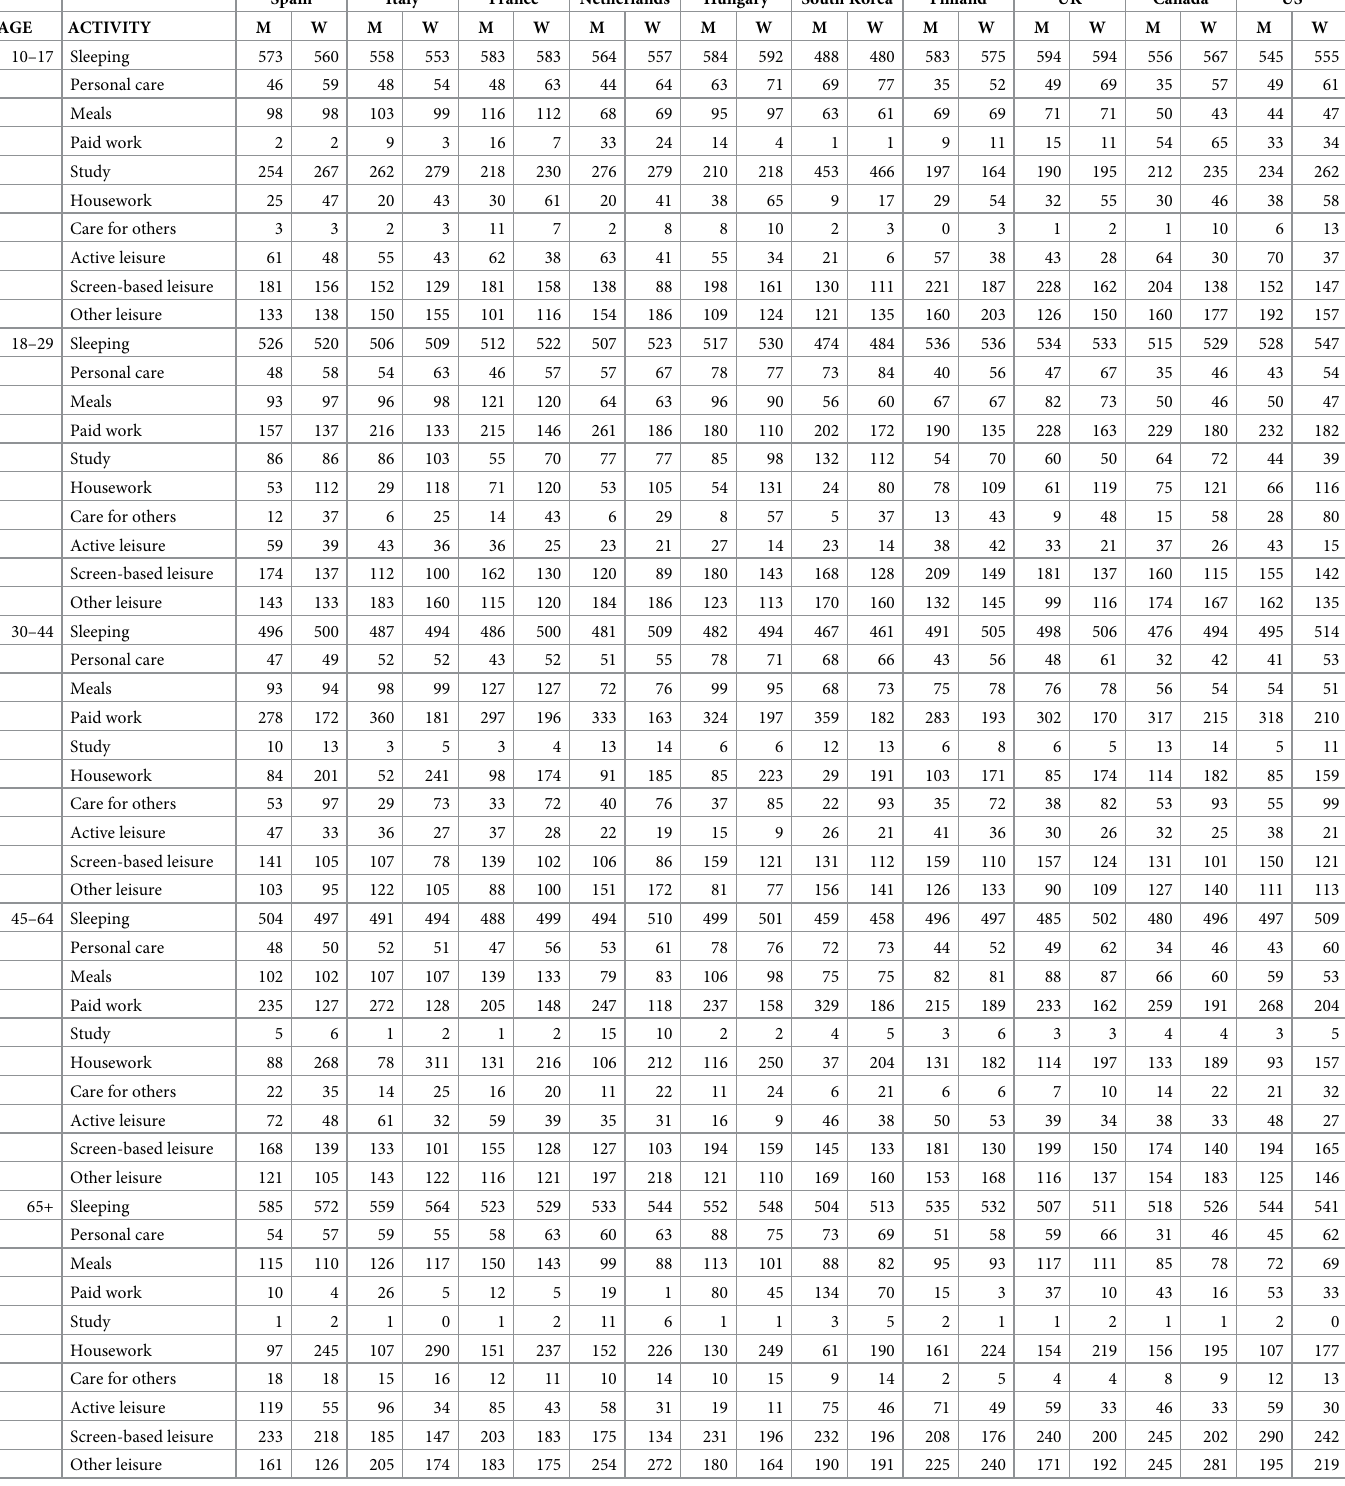
Table 3. Average time by activity and age. Men’s and women’s daily minutes by